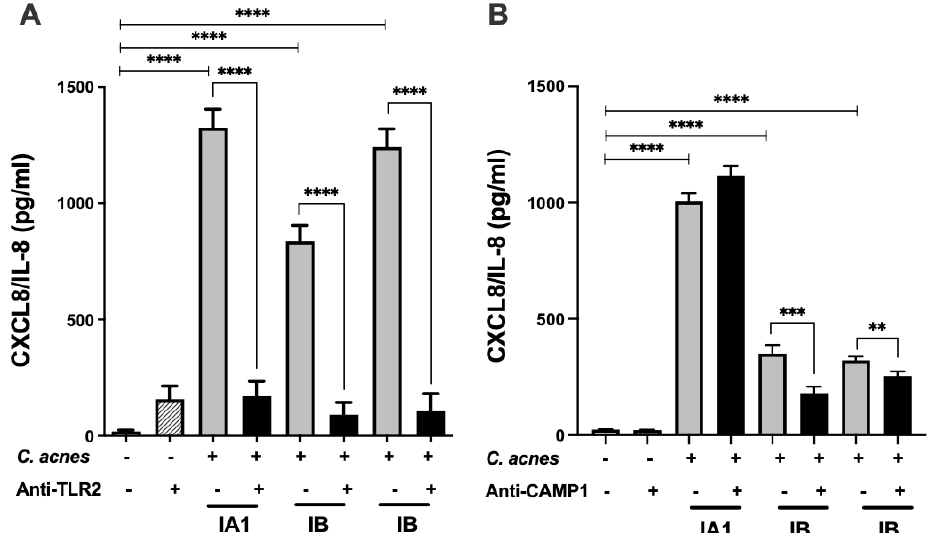
Figure 2. Inhibition of C. acnes -induced CXCL8/IL-8 production by TLR-2 and CAMP1 antibodies. HaCaT cells were treated with ( A ) anti-TLR-2 antibody (1 µ g/mL) or ( B ) anti-CAMP1 antibody (1 µ g/mL) for 24 h (gray bar), and were then stimulated with various strains of C. acnes (multiplicy of infection 15 (MOI 15) (phylotype IA1, strain 6919; phylotype IB, strains PIE and 14230) for 18 h (dark bar). Control experiments correspond to C. acnes stimulation of HaCaT cells only (gray bar). CXCL8/IL-8 production was measured by ELISA. Statistical significance is indicated by ** ( p < 0.01), *** ( p < 0.001) and **** ( p < 0.0001).